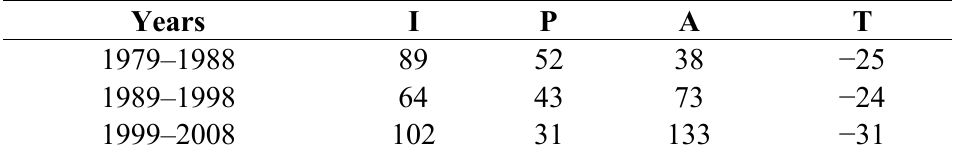
Table 2. CO emissions and driving forces in urban China (growth in %). 2